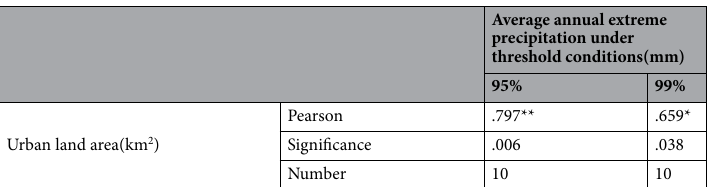
Average annual extreme precipitation